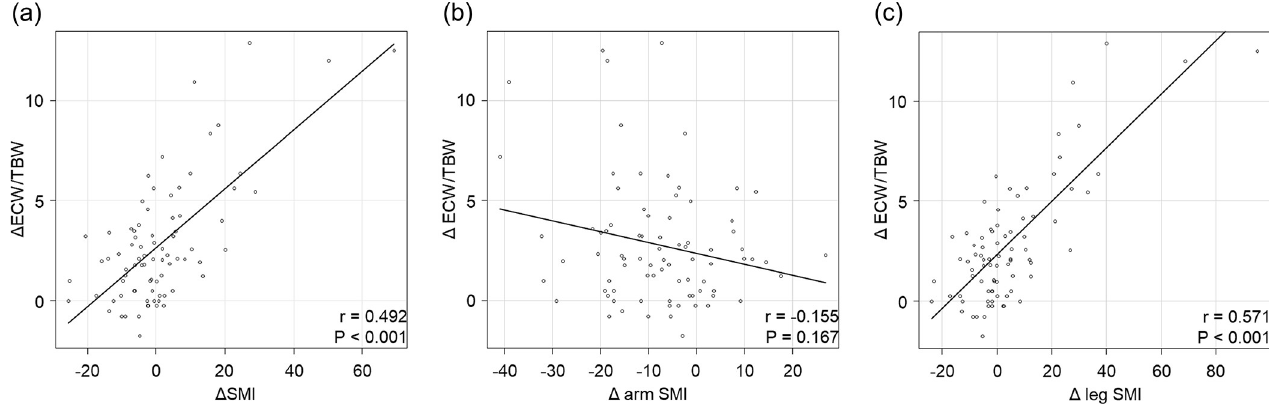
Fig 5. Correlation between the rate of change in ECW/TBW and that for each SMI measure. (a) Total SMI, (b) arm SMI, and (c) leg SMI. (b) The ECW/ TBW and arm SMI were not correlated with the rate of change (r = − 0.155, P = 0.167). (a) The rate of change of the ECW/TBW and total SMI and (c) that of ECW/TBW and leg SMI were positively correlated (r = 0.492, P < 0.001 and r = 0.571, P <